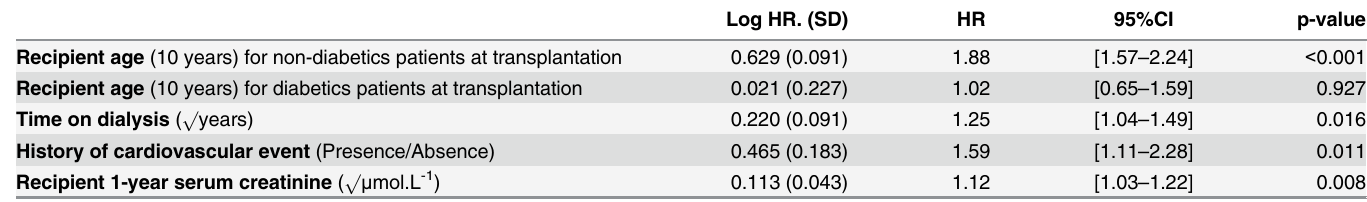
Table 3. Results of the multivariable parametric survival model from the training sample (n = 2291). The scale and the shape parameters of the base- line Weibull hazard function were respectively equaled 2635.742 (SD = 0.671) and 1.318 (SD =